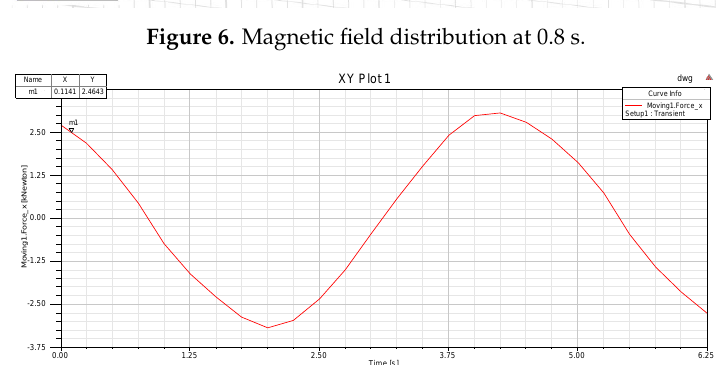
Figure 7. Thrust force profile versus